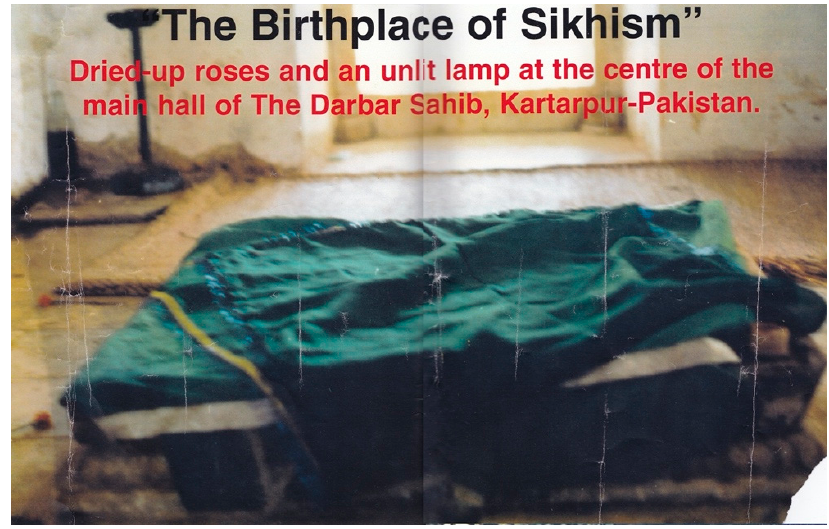
Figure 2. This photo was taken by Dr. Attariwala showing the interior of Darbar Sahib during his